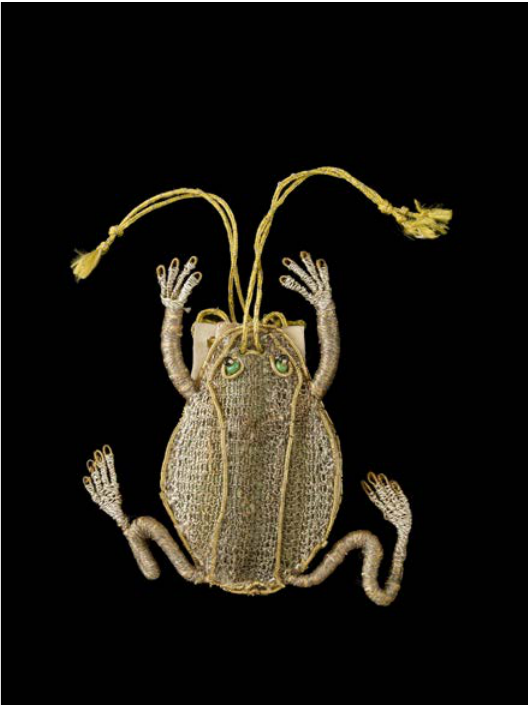
Figure 1 – ‘Frog Purse’, 17 th Century, silk and metal threads, silk floss, silk fabric, leather (?), metal purl, wire, and glass beads, 6 cm x 7.5 cm x 1.5 cm. WA1947.191.324 Anonymous, Frog Purse Image © Ashmolean Museum, University of Oxford